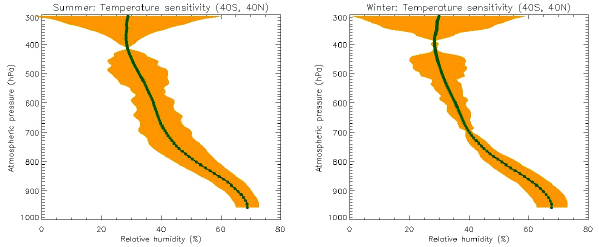
Figure 5. GPSRO RH sensitivity error analysis on ± 1.0K tempera- ture uncertainty for summer (left) and winter (right), using 1 year of data from 2007, as a function of pressure level. The orange shaded region shows the boundaries of the